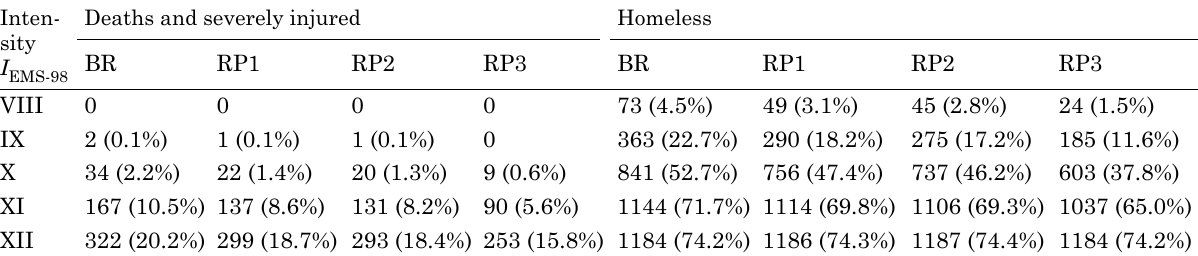
Table 6. Estimation of the number of deaths and severely injured, and homeless, for a total number of 1596 inhabitants inten - Deaths and severely injured sity I EMS-98